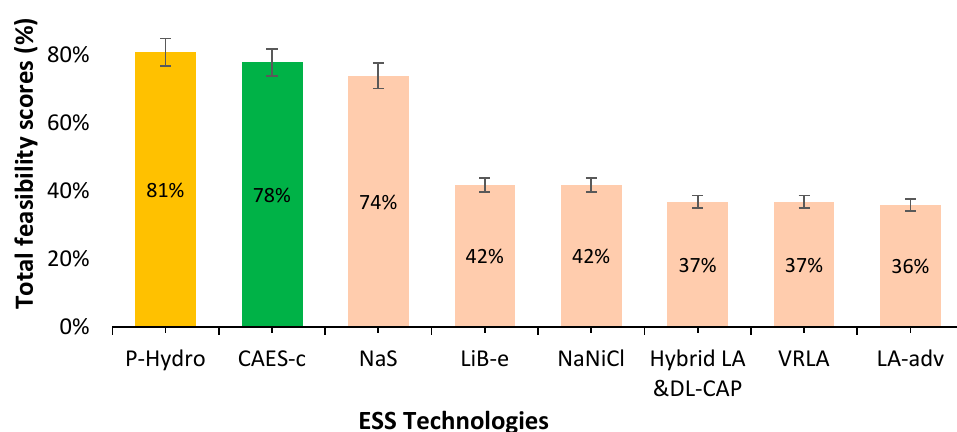
Figure 7. Analysis of overall feasibility scores for different ESS applied at central or bulk generation level (%) meeting application requirement, ALCM criteria, and total installation cost (USD/kW or USD/kWh) for a weight factor of 1.0.